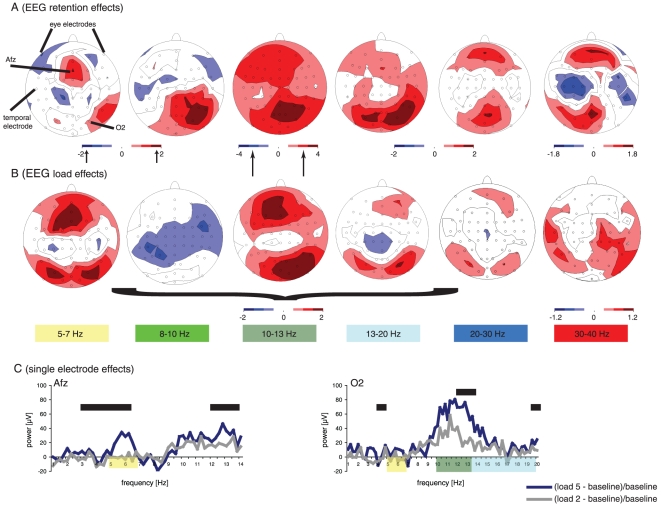
Illustration of EEG results during the retention interval.(A) Load independent topographical EEG effects. Results are reported for the following frequency bands: theta (5–7 Hz), alpha1 (8–10 Hz), alpha2 (10–13 Hz), beta1 (13–20 Hz), beta2 (20–30 Hz) and gamma (30–40 Hz). (B) Load dependent topographical EEG effects (‘(ss5–ss2)/ss2’). Significance values (t-tests, short arrow: p<0.05 and long arrow: p<0.01, uncorrected) for both analysis are indicated by a white-to-red (positive effects) and white-to-dark blue (negative effects) colour scale. (C) Results for single electrodes Afz and O2. For Afz, load 5 (dark-blue curve) exhibits stronger theta (yellow rectangle) power than load 2 (grey curve). For O2, alpha2 (light-green rectangle) and beta1 (light-blue rectangle) power is more enhanced for load 5 than for load 2. The black bars indicate significant effects at p<0.05 (corrected for multiple comparisons using the FDR). No significant load independent- or load dependent EEG effects occur at eye electrodes or at temporal (muscle) electrodes.